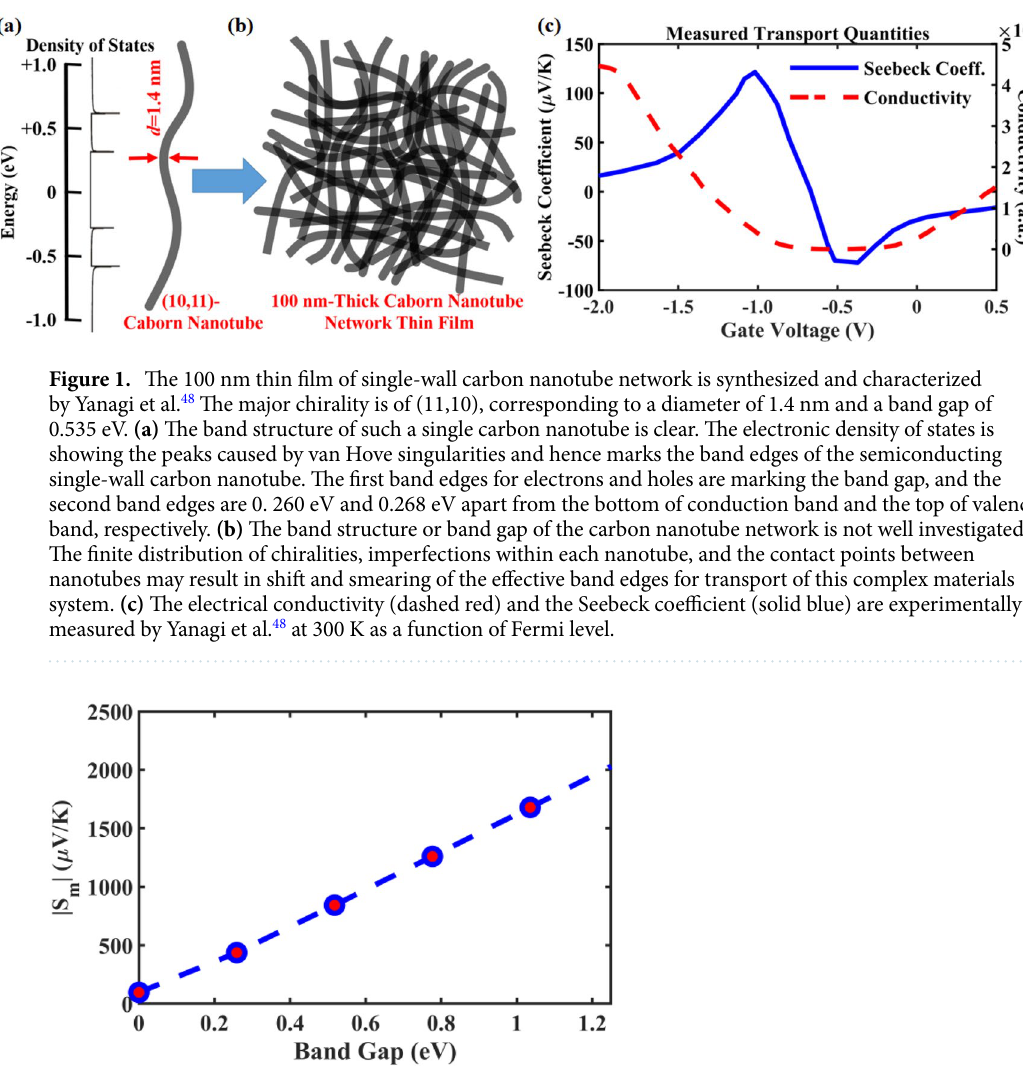
Figure 2. Illustration of how the highest achievable Seebeck coefficient increases with the band gap. Suppose we have a hypothetical carbon material, in which we can fix the mechanism(s) of charge carrier transport and scatterings at T = 300 K, and only change the band gap. Specifically, we fix the energy sensitivity to transport at s = 1.0 and the asymmetry of transport rates between the holes and the electrons at γ = 1.5. This is a demonstration on how the maximum Seebeck coefficient ( p -type) monotonically increases with the band